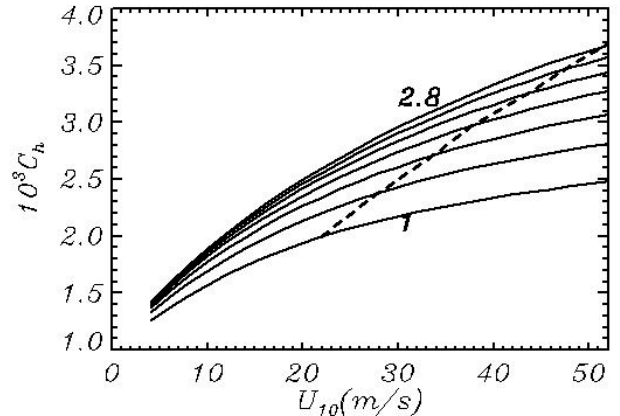
Ω = Ω = 1 and 2.8 are marked (see capture to Figure 8). p p